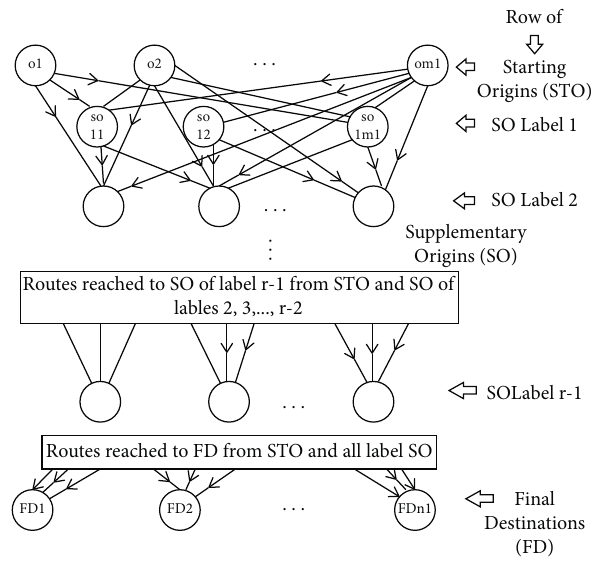
Figure 1: Graphical representation of